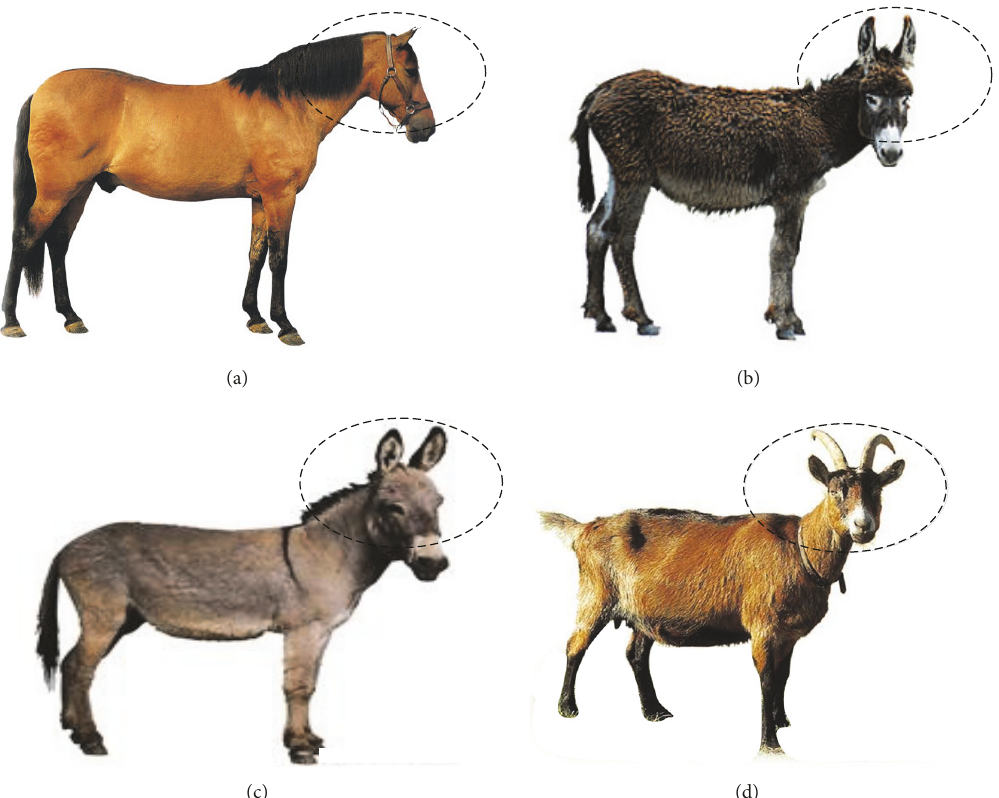
Figure 3: Target objects for cognition simulation: (a) horse, (b) donkey, (c) mule, (d) goat.